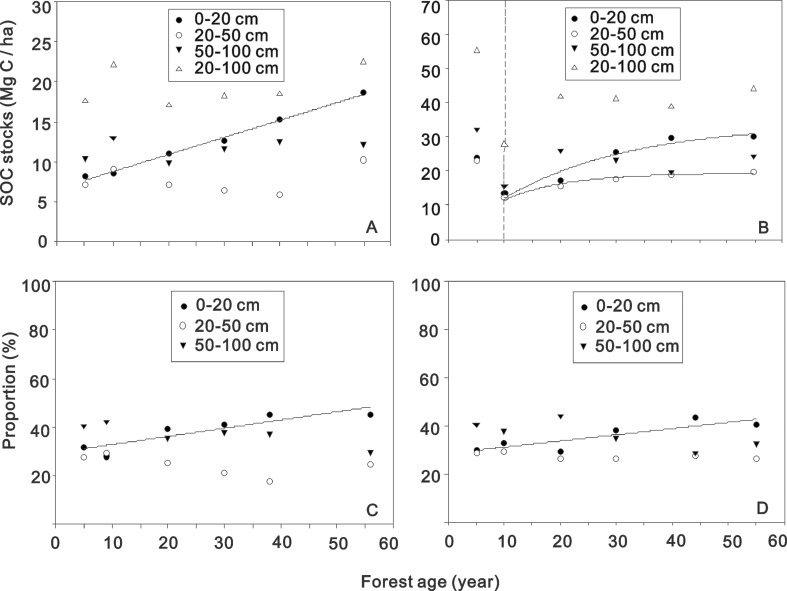
Soil organic C stocks (A, B) and the proportions of each layer’ SOC stock to total SOC (C, D) in different soil depths across the chronosequence in two climate zones.(A): drier zone, y = 6.68 + 0.21 x (R2 = 0.99, P < 0.001; 0–20 cm); (B): wetter zone, y1 = 33.84 * (1—exp (−0.04 x)) (R2 = 0.94, P = 0.005, 0–20 cm), y2 = 19.42 * (1—exp (−0.09 x)) (R2 = 0.98, P = 0.002, 20–50 cm), x∈[10, 55], the dotted line separates two stages of C stock change during the stand development; (C): drier zone, y = 0.297 + 0.003 x (R2 = 0.80, P = 0.016, 0–20 cm); (D): wetter zone, y = 0.285+ 0.003 x (R2 = 0.76, P = 0.024, 0–20 cm).